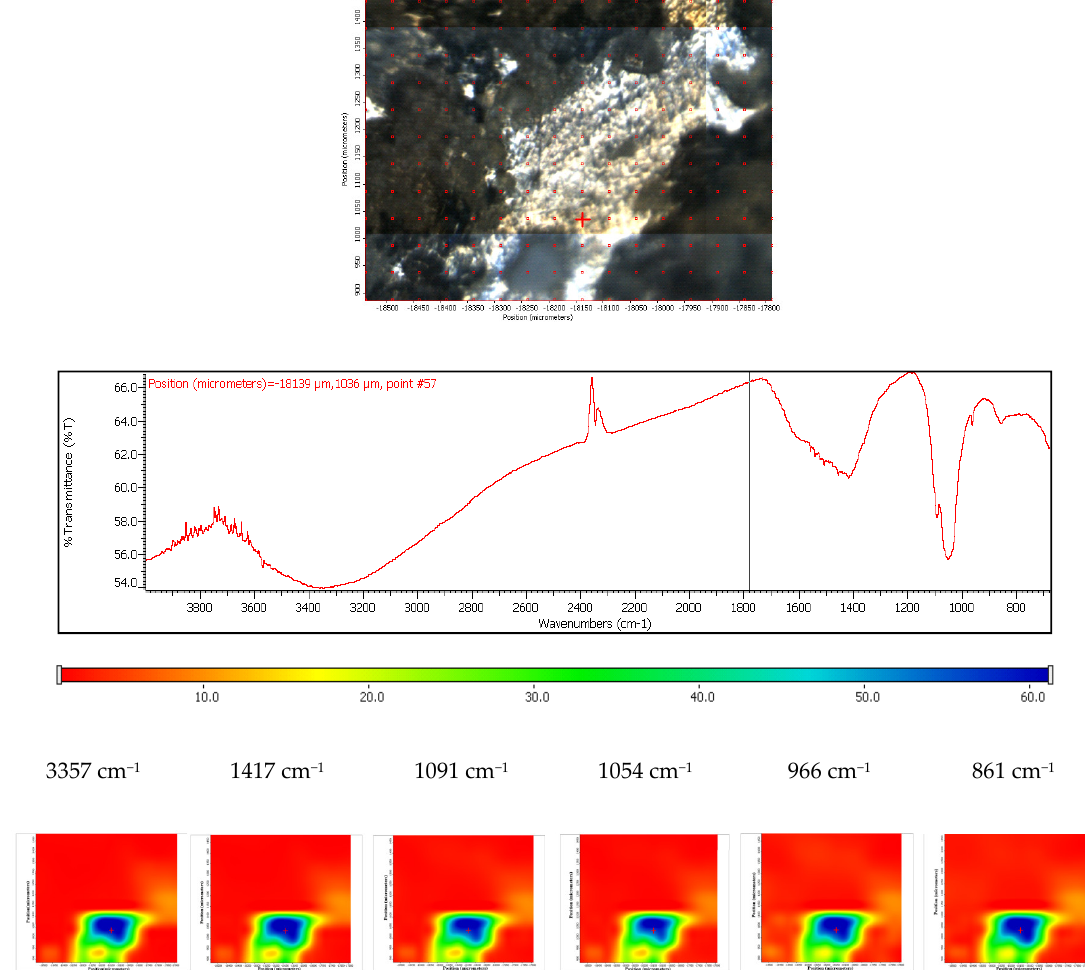
Figure 20. FTIR diagram and chemigram maps of the coated ZMX 410 alloy exposed to SBF. In the upper part, a dark field optical image, corresponding to the investigated area, is presented. In the lower part, false colour maps with the indicated reference bands are shown. The chemigram scale bars are expressed in μm.